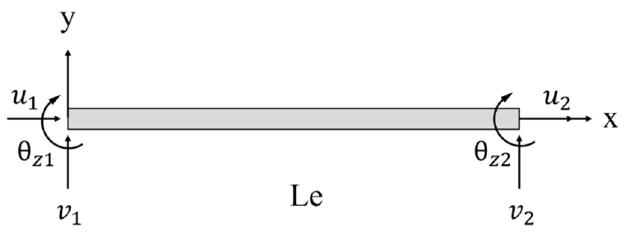
Figure 2. Two-node inverse-beam element.